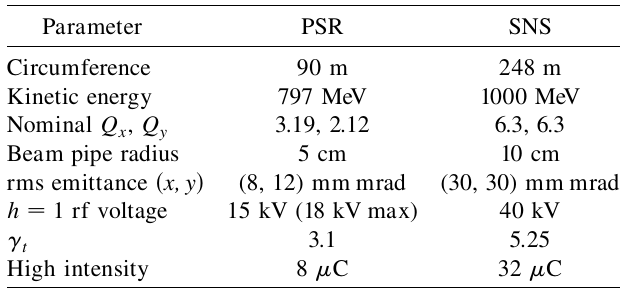
TABLE I. Machine parameters for the PSR and SNS. Parameter